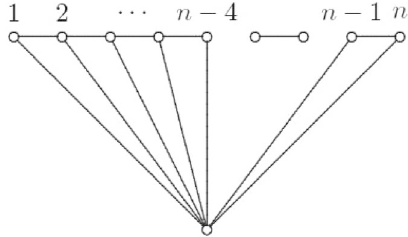
Fig. 5 Reduced fan after three applications of Theorem 2.5